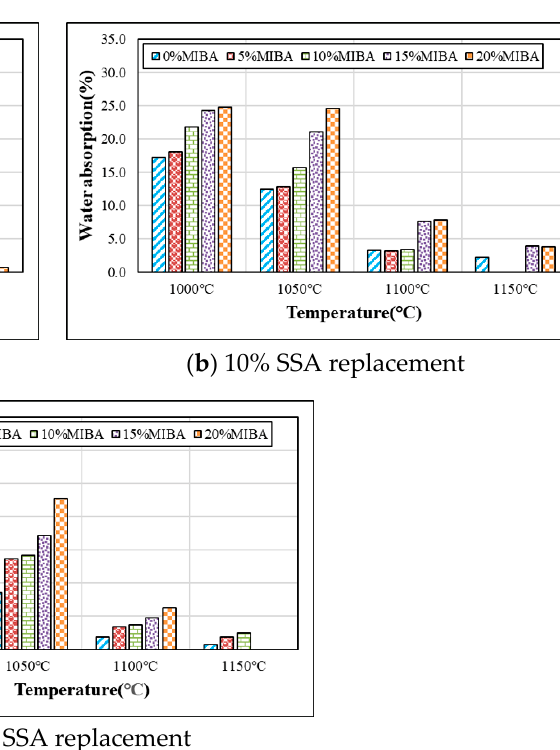
( d ) 1150 °C Figure 6. Specific gravity of specimens at different sintering temperature. ( a ) 1000 °C; ( b ) 1050 °C; ( c ) 1100 °C; ( d ) 1150 °C.